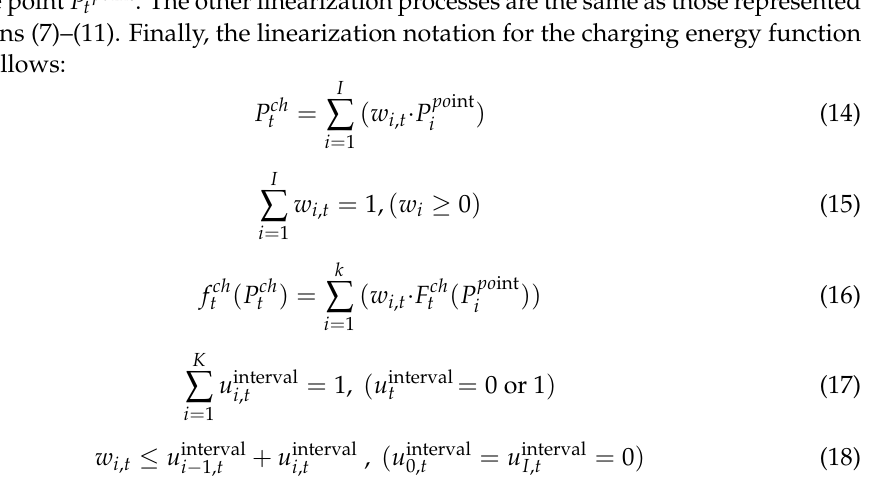
F and dis F . t t